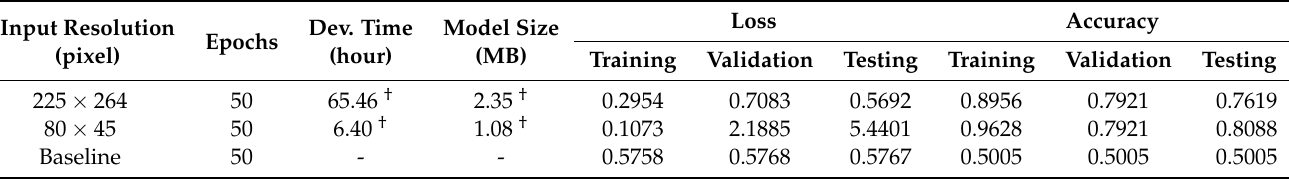
Table 3. Model size, development time, and performance of both